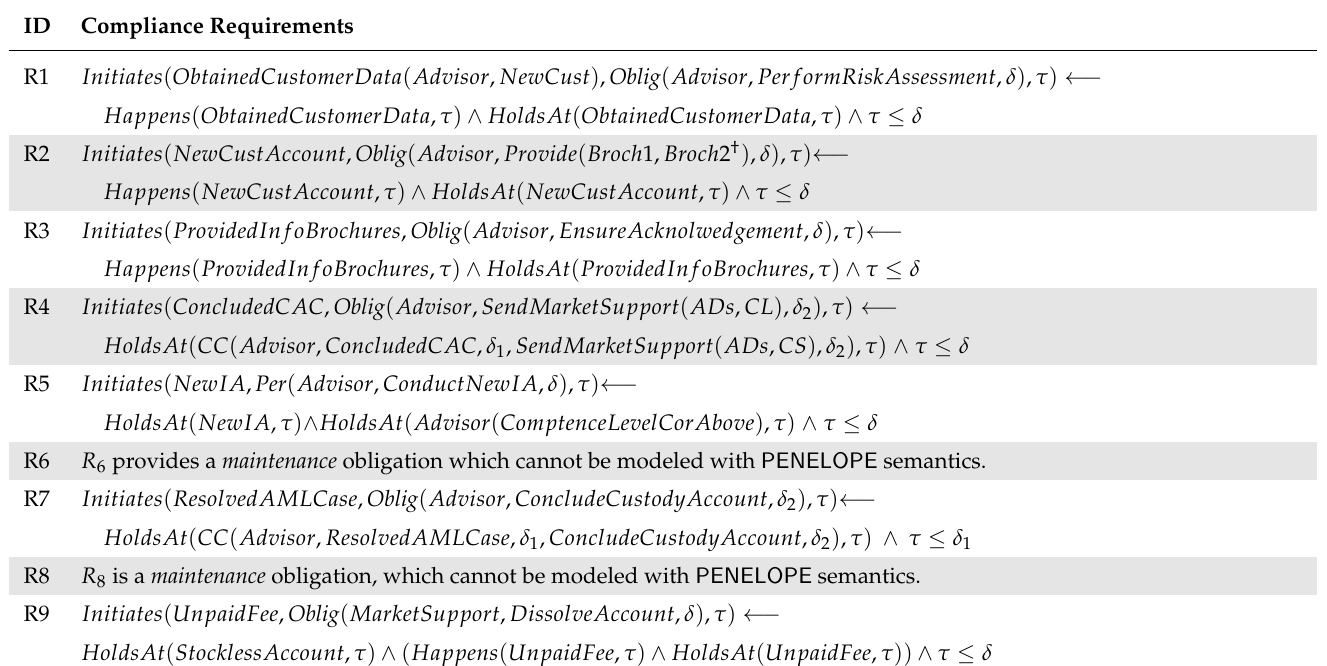
Table 15. Formalised requirements using PENELOPE patterns in EC